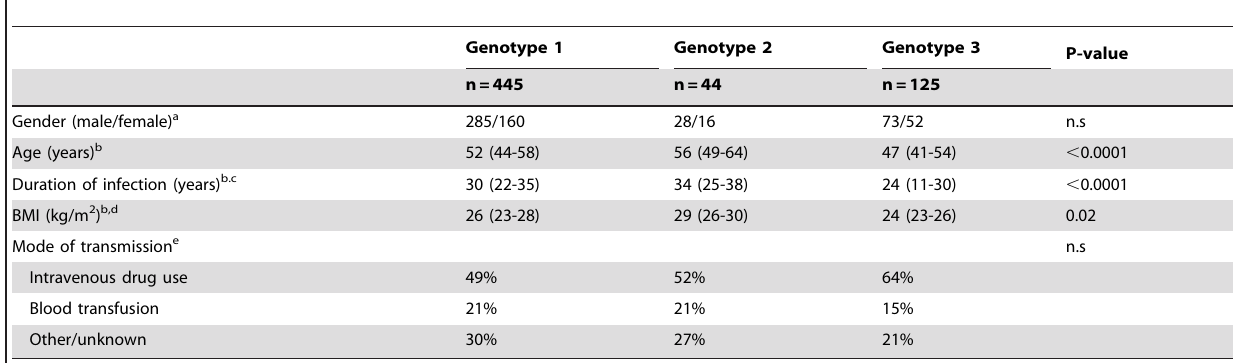
Table 1. Baseline characteristics of patients with a valid liver stiffness